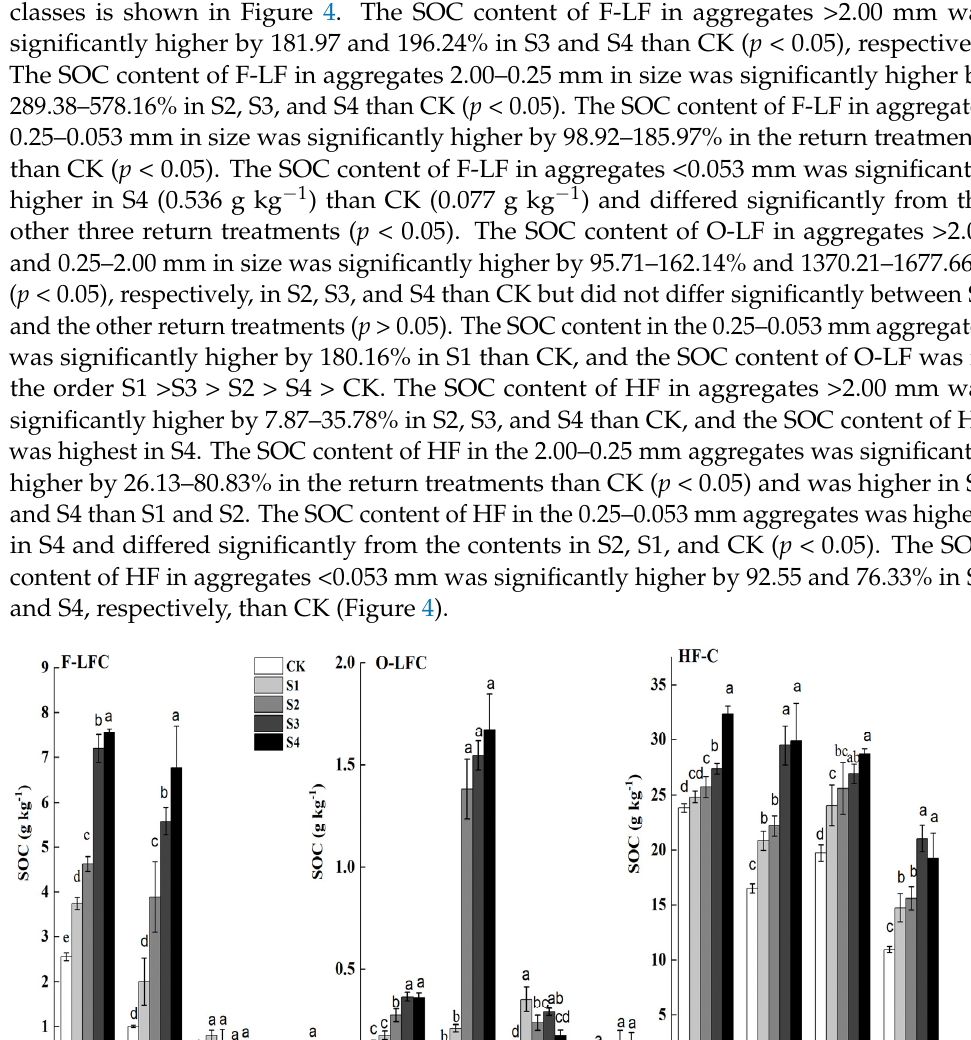
Figure 5. Structural equation model of the relationships among straw return, soil organic carbon indicators, and aggregate indicators. Red lines indicate positive relationships, dashed black lines indicate negative relationships, and black lines indicate non-significant relationships. Numbers as- sociated with the lines are correlation coefficients. Arrow width indicates the strength of significant standardized path coefficients. R 2 above each response variable in the model denotes the proportion